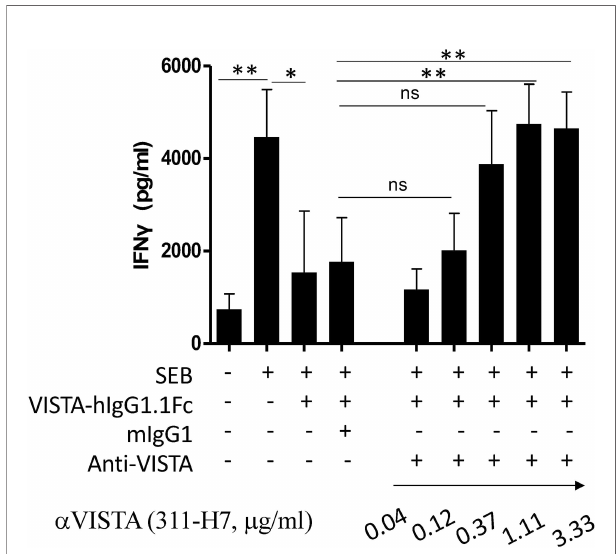
FIGURE 1 | Generation of one neutralizing monoclonal antibody against human VISTA. Peripheral blood mononuclear cells (PBMCs) were cultured in the presence or absence of superantigen staphylococcal enterotoxin B (SEB), and the culture supernatant was analyzed by ELISA for IFN- g secretion. VISTA-hIgG1.1Fc, mIgG1, and 311-H7 were added into the indicated wells. The experiment was done in triplicate. Four independent experiments show similar results. * p < 0.05, ** p < 0.01. ns, not signi fi